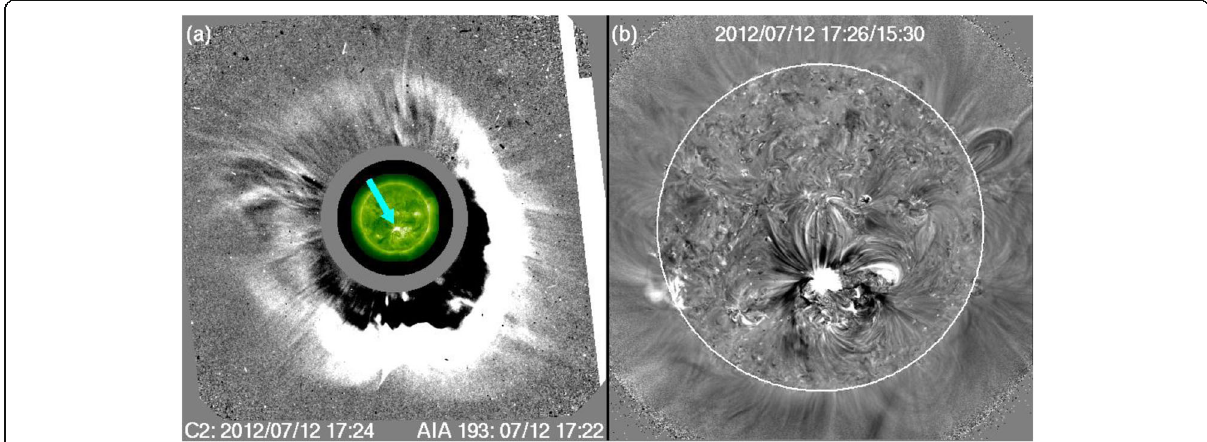
Fig. 16 Images showing the solar source region of Event #1 on 12 July 2012. Left: SOHO/LASCO running difference image showing the full halo CME on 12 July, 17:24 UT. Superimposed within the occulting disk area is a near-simultaneous SDO/AIA 193 Å image with an arrow pointing to the near-disk center flare and dimming in AR 11520. This image is from the SOHO/LASCO CDAW CME catalog. Right: Enlarged AIA base difference image of the source